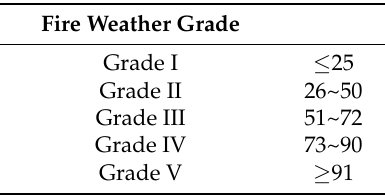
Table 2. Forest fire weather grade